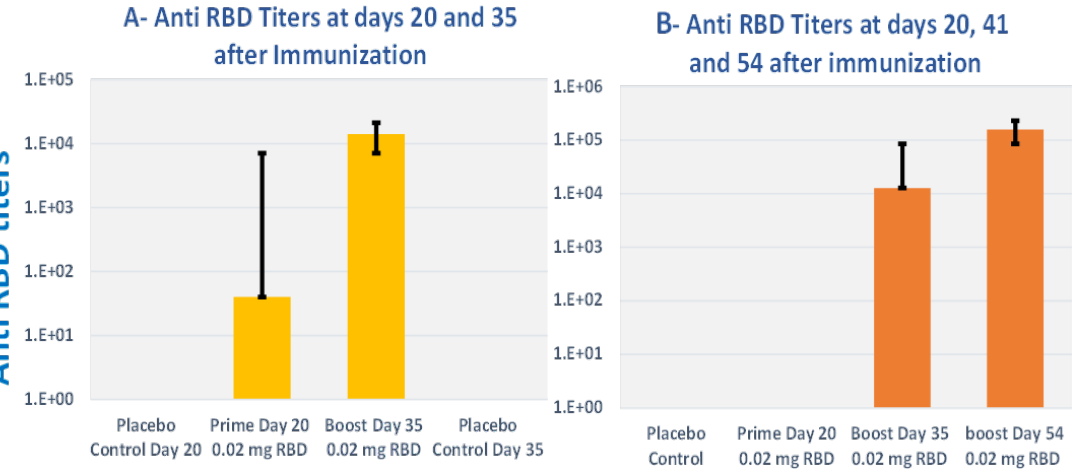
Figure 8. Serum antibody responses generated by Alhydrogel ® ‘85’ adjuvanted C1-RBD-C-tag anti- gen in K18-hACE2 transgenic C57BL/6J mice: ( A ) reciprocal end-point titers of anti-RBD-C-tag immunoglobulin antibody in sera from K18-hACE2 C57BL/6J transgenic mice immunized twice, each time subcutaneously with 640 µg of Alhydrogel ® ‘85’ adjuvant and 20 µg RBD-C-tag antigen, 20-days after 1st immunization, Prime and 14-days after the second immunization, Boost; and ( B ) anti-RBD-C-tag immunoglobulin titers of mice immunized three times, 20 days after the first immunization, Prime, 20 days after the second immunization, Boost 1, and 13 days after the third immuniza- tion, Boost 2.